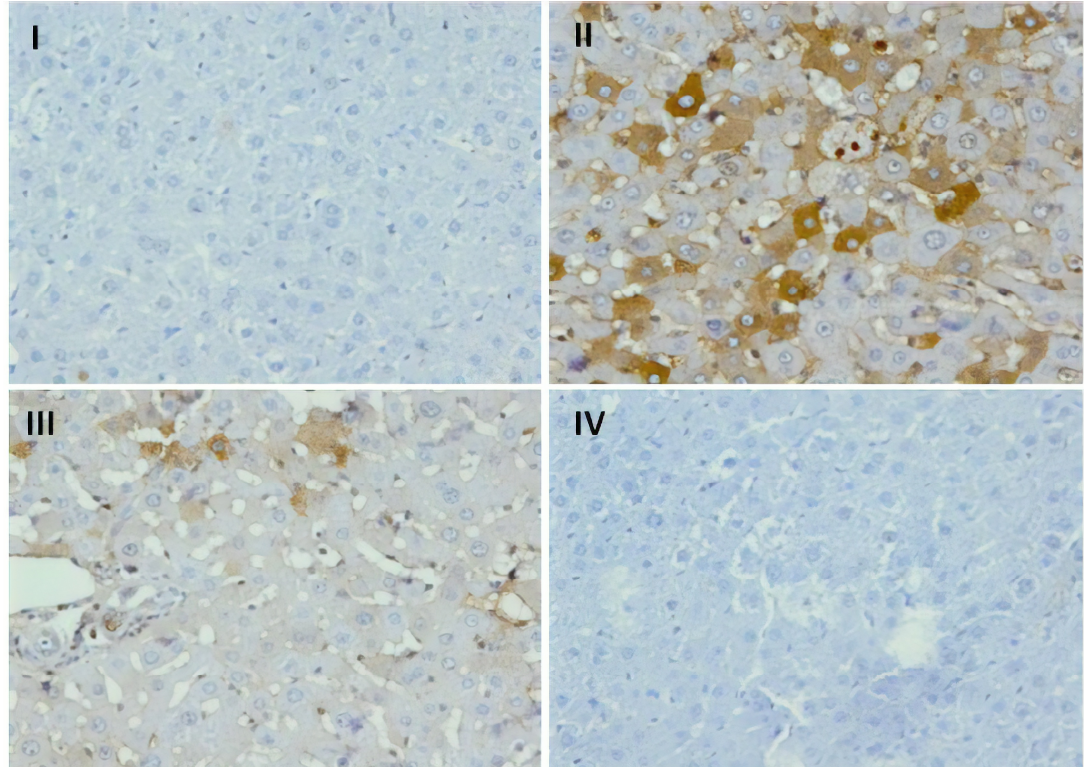
Figure 5. Effect of naringenin treatment on Cox-2 expression. Photomicrographs of hepatic sections depicting immunohistochemical analyses, brown color indicates specific immunostaining of Cox-2 and light blue color indicates counter staining by nuclear hematoxylin. The hepatic section of Dox-treated group II has more Cox-2 immunopositive staining as indicated by brown color as compared to the control group I, whereas treatment of naringenin (50 and 100 mg/kg b. wt.) in groups III and IV reduced Cox-2 immunostaining as compared to group II. Original magnification: 40×.